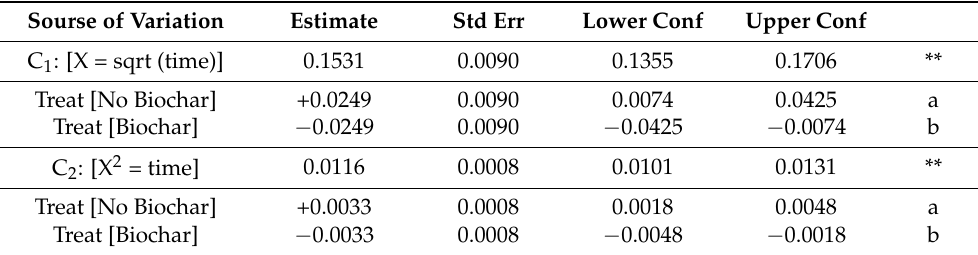
Table 8. Results of the stepwise procedure in application of the Philip’s cumulative infiltration model to the six soil–biochar mixtures. Biochar treatments (B2, B4, B6, B8 and B10) were grouped because they were not statistically different from each other. B0 remained statistically separated from the other treatments. The standard error of the estimates, together with their confidence intervals at 95% of probability are also reported.